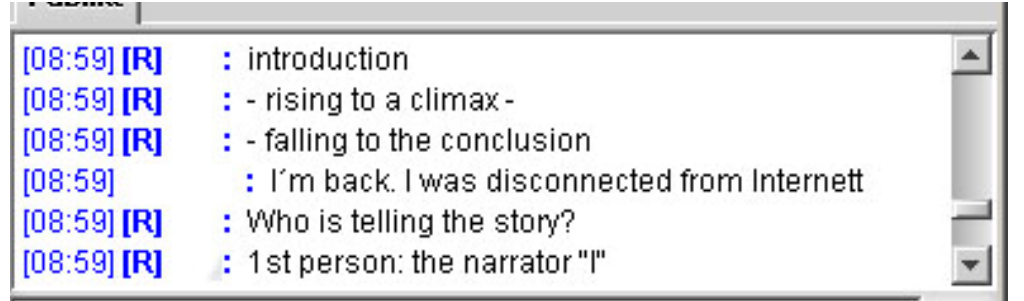
Figure 2 . Connectivity problems. A student reports his return to the seminar, entering in the middle of a side discussion using the text chat function between some students (names removed from image).